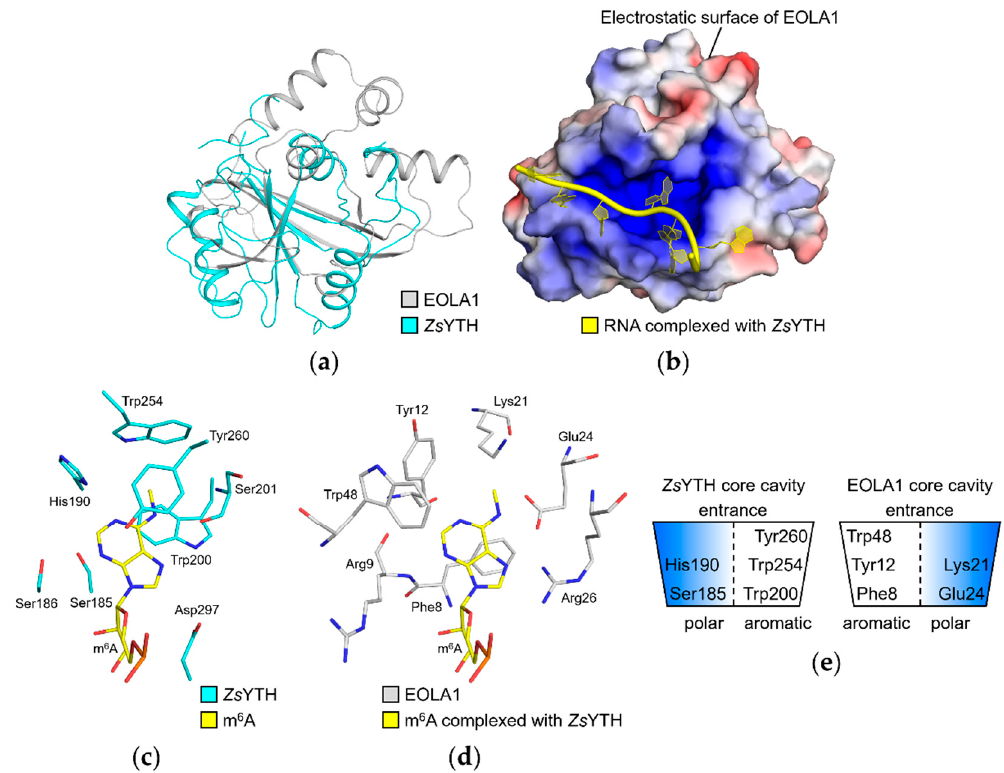
Figure 4. Prediction of interaction of EOLA1 with nucleotides. ( a ) Superimposition of EOLA1 and Zygosaccharomyces rouxii YTH domain ( Zs YTH) structures. The crystal structures of EOLA1 and Zs YTH (PDB ID: 4U8T) in complex with RNA are shown as gray and cyan cartoon models, respectively. The RNA molecule is not shown. ( b ) The electrostatic potential surface of EOLA1 superimposed with RNA. Negative and positive surfaces are colored in red and blue, respectively. The RNA molecule complexed with Zs YTH is shown as a yellow cartoon, and Zs YTH structure is not shown. ( c ) The core-cavity residues of Zs YTH. The Zs YTH residues forming hydrogen bonds or stacking interactions with the methylated adenosine are shown as cyan sticks. The N6-methylated adenine (m 6 A) is shown as yellow sticks. Nitrogen and oxygen atoms are colored in blue and red, respectively. ( d ) The core-cavity residues of EOLA1. The EOLA1 residues forming stacking or hydrogen-bond interactions with the m 6 A-RNA model from the Zs YTH-EOLA1 superimposed structure ( b ) are shown as gray sticks. Nitrogen and oxygen atoms are colored as in ( c ). ( e ) Schematic representation of core cavities of EOLA1 and Zs YTH. Aromatic and polar sides in the cavities are colored in white and blue, respectively.